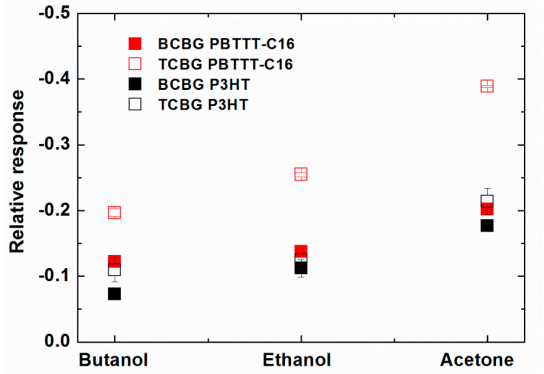
Figure 8. Relative response in equilibrium of all OTFTs-based sensors versus the three analytes: BCBG PBTTT-C16 (red full squares), TCBG PBTTT-C16 (red open squares), BCBG P3HT (black full squares) and TCBG P3HT (black open squares). The responses are evaluated based on the transient drain measurements. Error bars represent the standard error of mean experimental values, derived from three